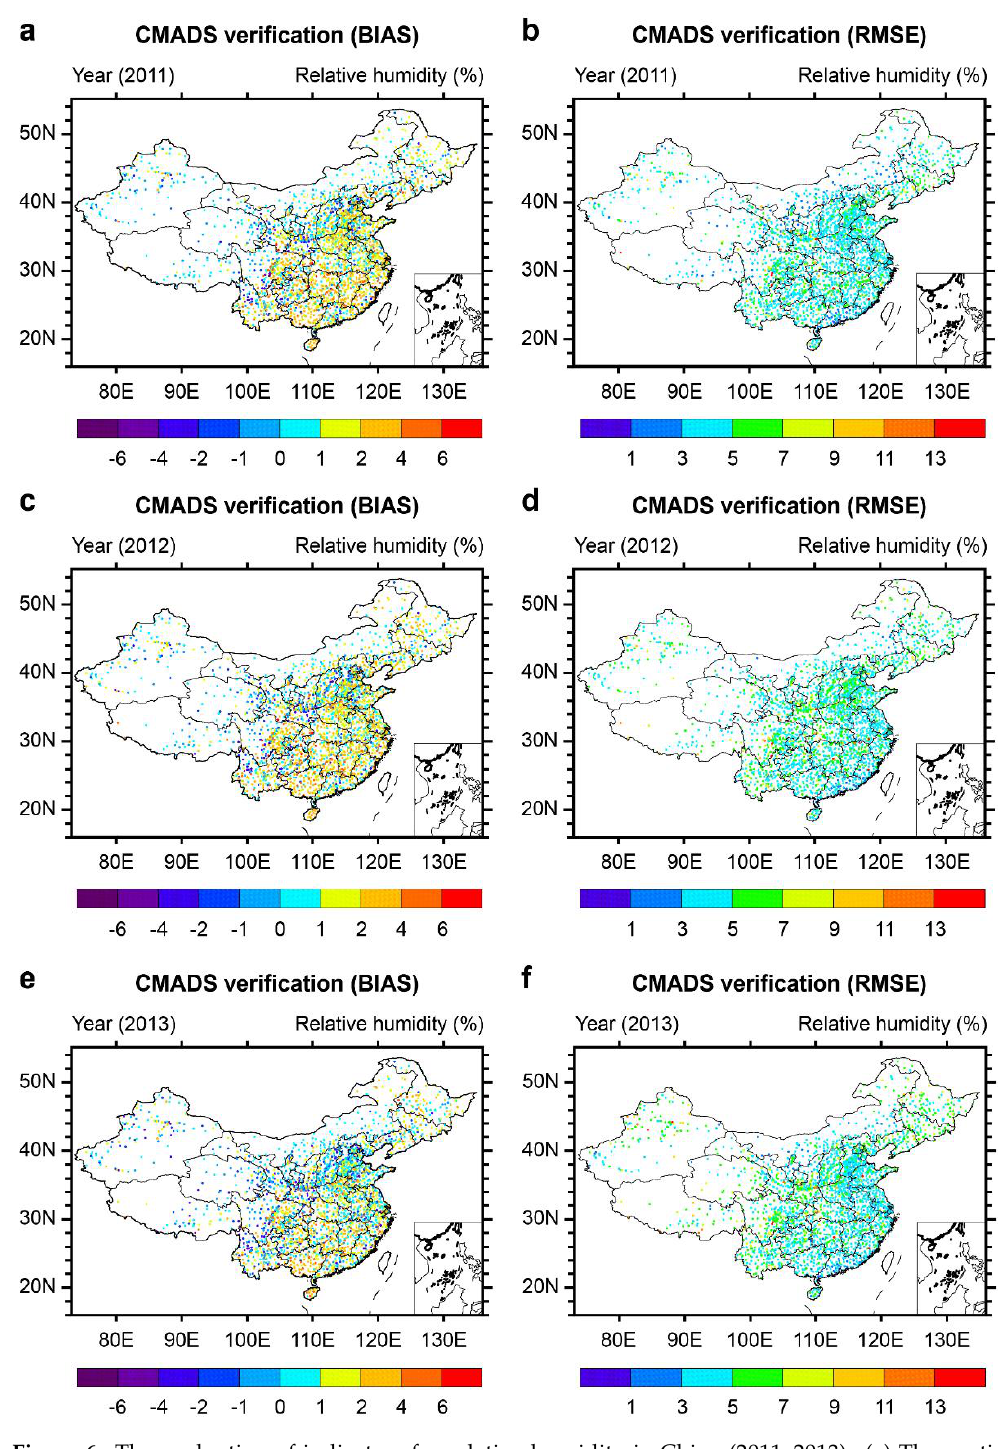
Figure 6. The evaluation of indicators for relative humidity in China (2011–2013). ( a ) The spatial distributions of the biases for the relative humidity in year 2011, ( b ) The spatial distributions of the RMSEs for the relative humidity in year 2011, ( c ) The spatial distributions of the biases for the relative humidity in year 2012, ( d ) The spatial distributions of the RMSEs for the relative humidity in year 2012, ( e ) The spatial distributions of the biases for the relative humidity in year 2013, ( f ) The spatial distributions of the RMSEs for the relative humidity in year 2013.